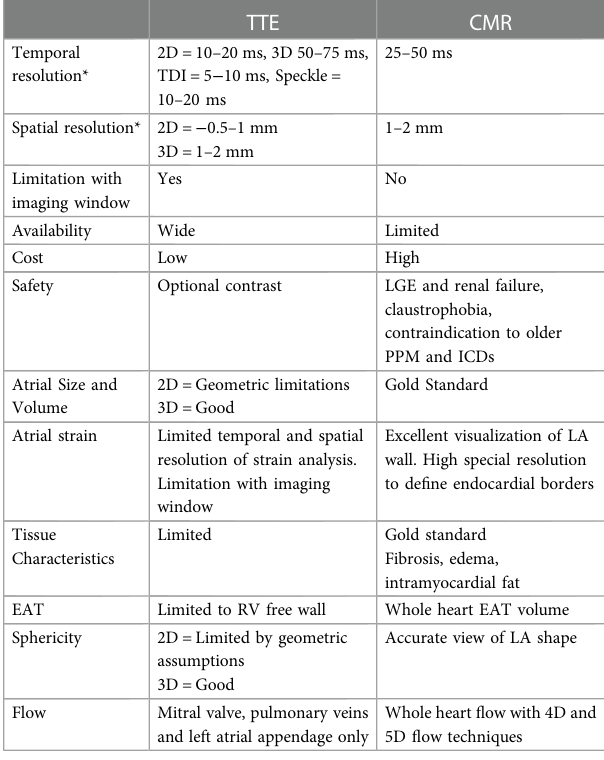
to de fi ne endocardial borders